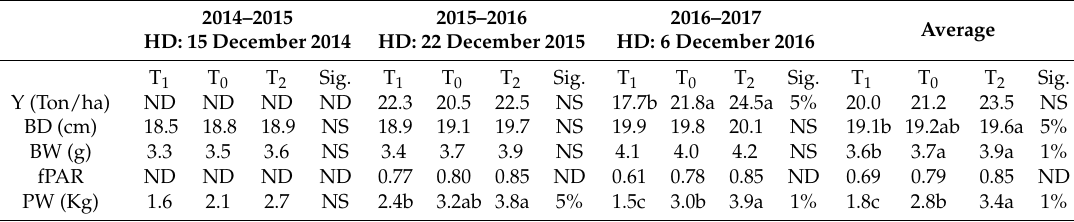
Table 1. Harvest date (HD), yield data (Y), berry diameter (BD), berry weight (BW), maximum fraction of photosynthetic active radiation intercepted by the vines (fPAR), and pruning weight per plant (PW) for the orchard monitored and the treatments induced in the field (T 0 , regular management of the orchard; T 1 , under-irrigation; and T 2 , over-irrigation). The significance of the differences (Sig.) was analyzed for each monitored campaign and for the average data. ND denotes “No Data”.